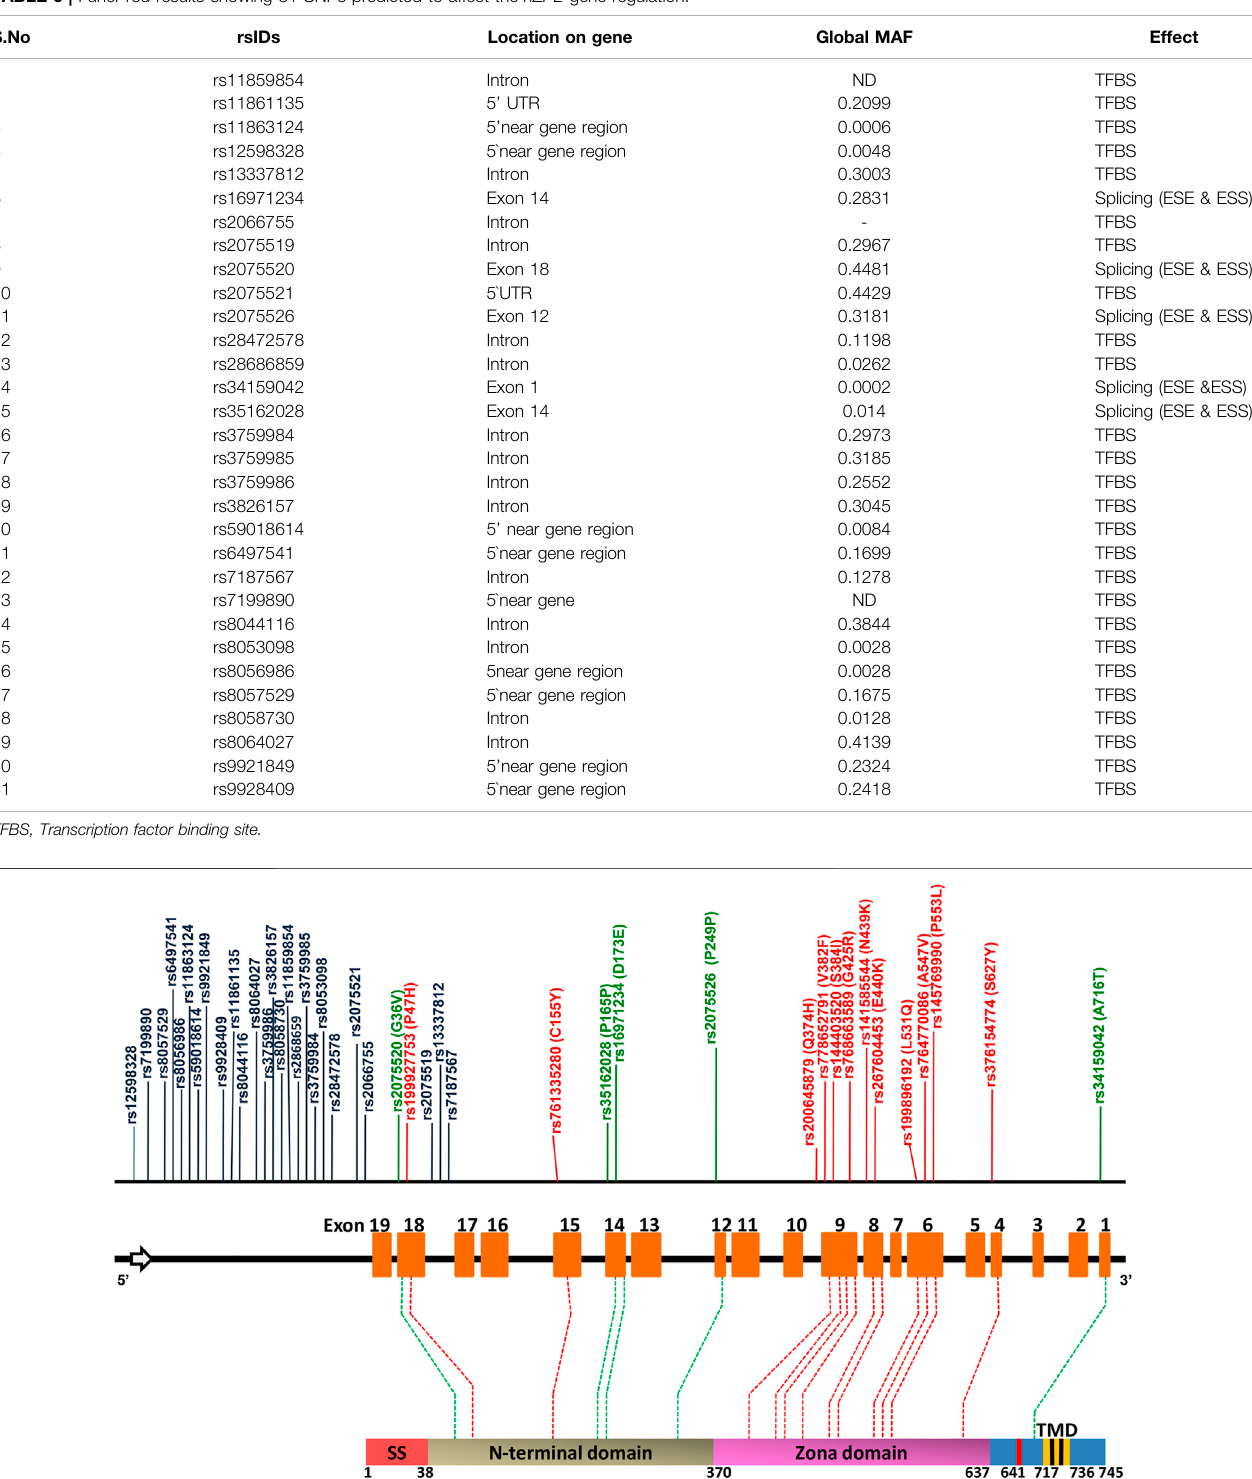
FIGURE 5 | A map of hZP2 gene and hZP2 protein, highlighting the positions of the various deleterious structural, functional and regulatory SNPs predicted by in silico analysis. Regulatory SNPs in the non-coding region are marked in black while those in the coding region are marked in green. Deleterious nsSNPs are marked in red. The sperm binding domain (aa 51 – 149) is present within the N-terminal domain. CFCS (cid:1) consensus furin cleavage site; SS (cid:1) signal sequence; TMD (cid:1) transmembrane domain.